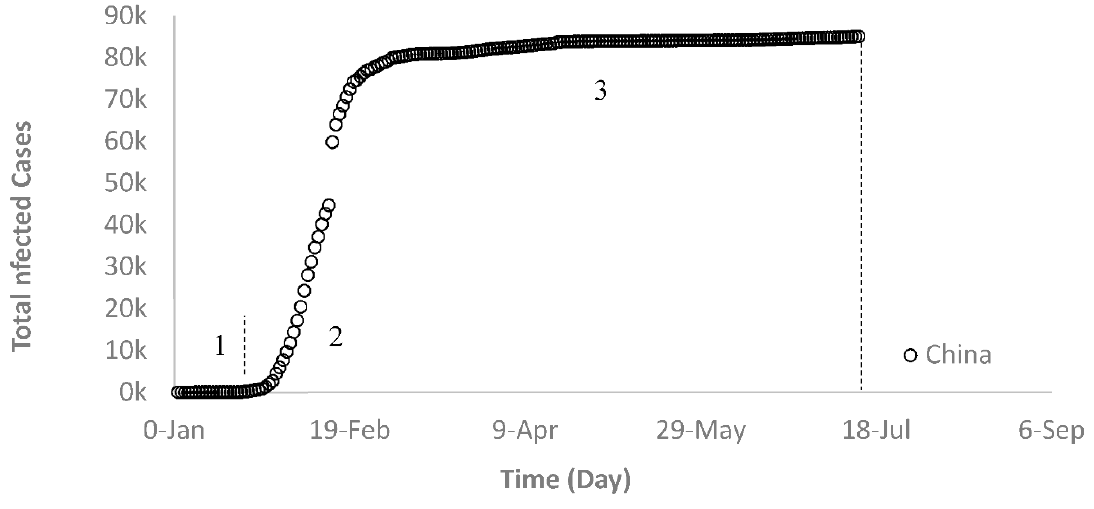
Figure 2. Growth trajectory of COVID-19 cases in China (Group A).